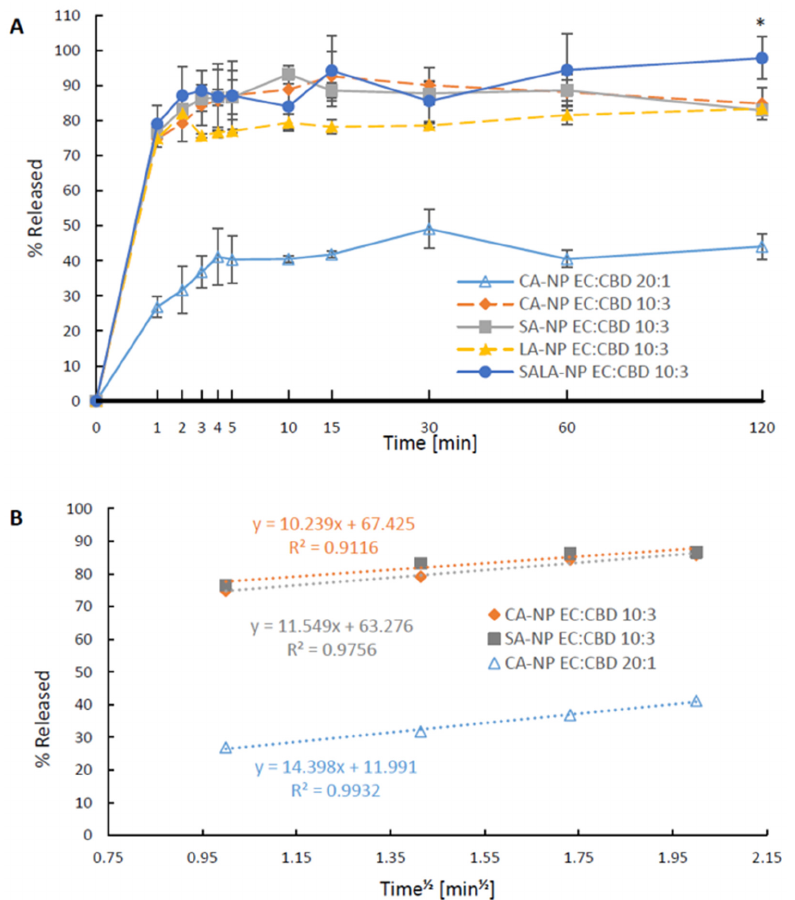
Figure 3. CBD release from LSNs: ( A ) comparison between CA-NPs, SA-NPs, LA-NPs, SALA-NPs, and CA-NPs containing a relatively higher ratio of ethyl cellulose/CBD, * p value < 0.05 between SALA-NP and other groups. p values calculated by one-way ANOVA, followed by post hoc Tuckey test at 120 min interval, values are presented as mean ± SD; and ( B ) Linear CBD release patterns from LSNs fitted the Higuchi model.